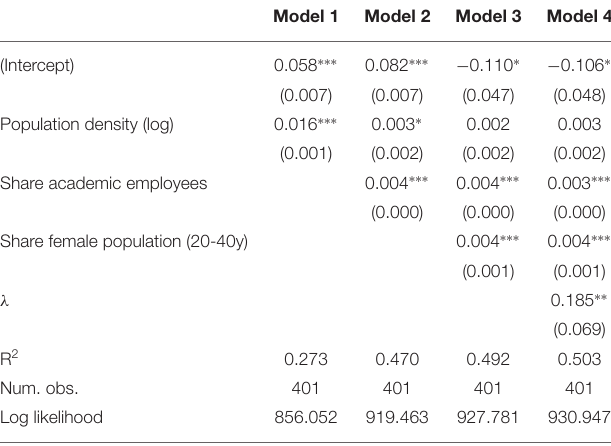
TABLE 5 | Regression models of the proportion of gender-inclusive language users in NUTS-3